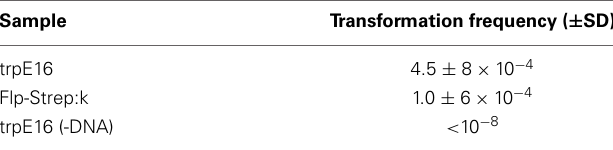
Table 2 | Transformation frequency of the M. luteus strain Flp-Strep:k. Sample